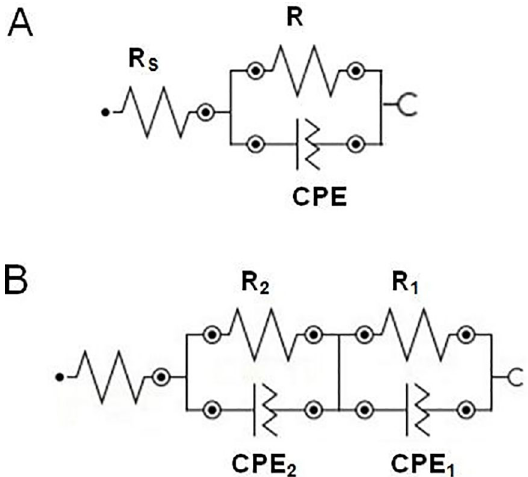
Figure 7. Equivalent circuit model used to simulate the EIS data of the selected systems. (A) Carbon steel substrate, Experiments 3, 3`and 4’; (B) Experiment